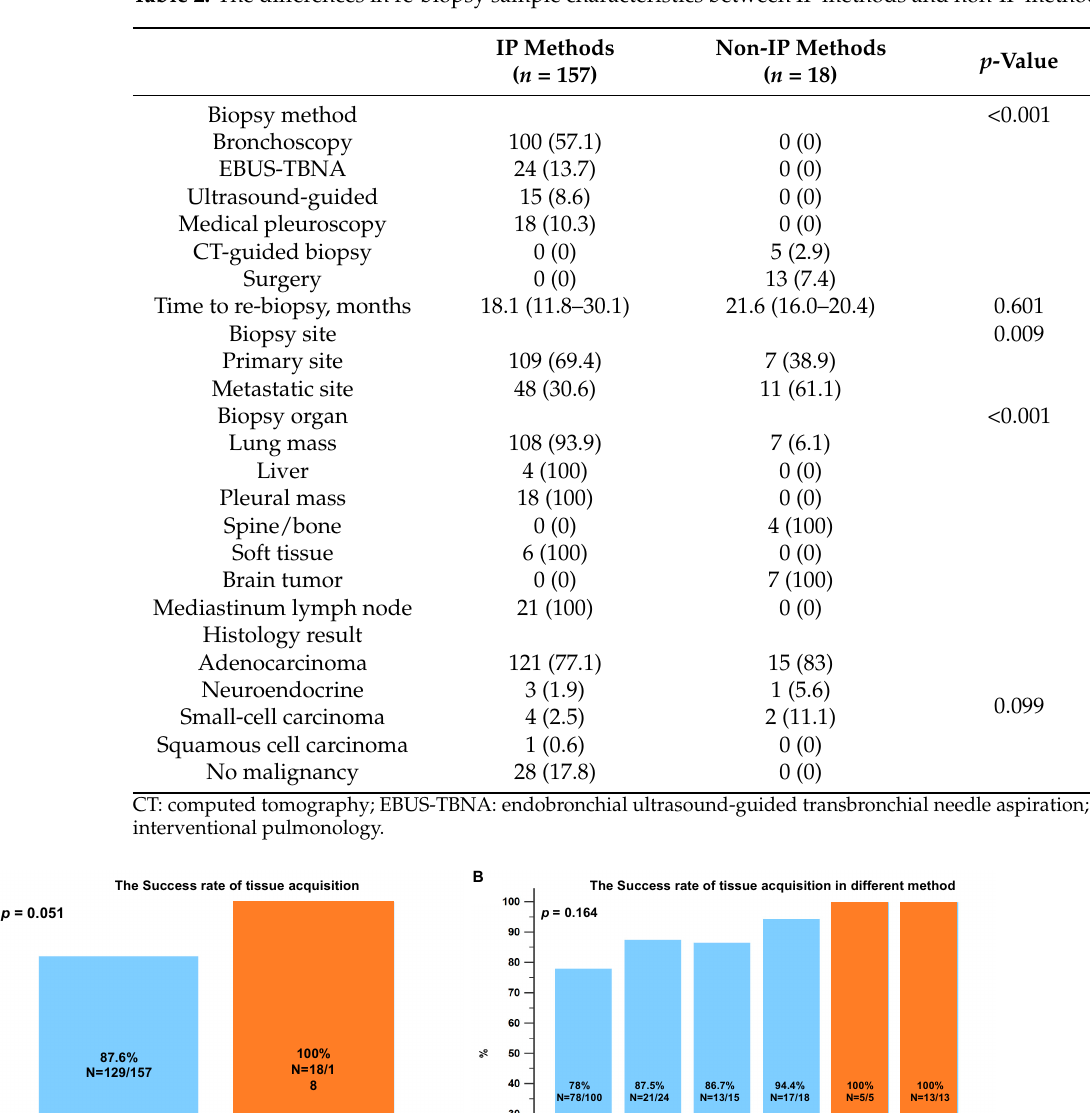
Table 2. The differences in re-biopsy sample characteristics between IP methods and non-IP methods.